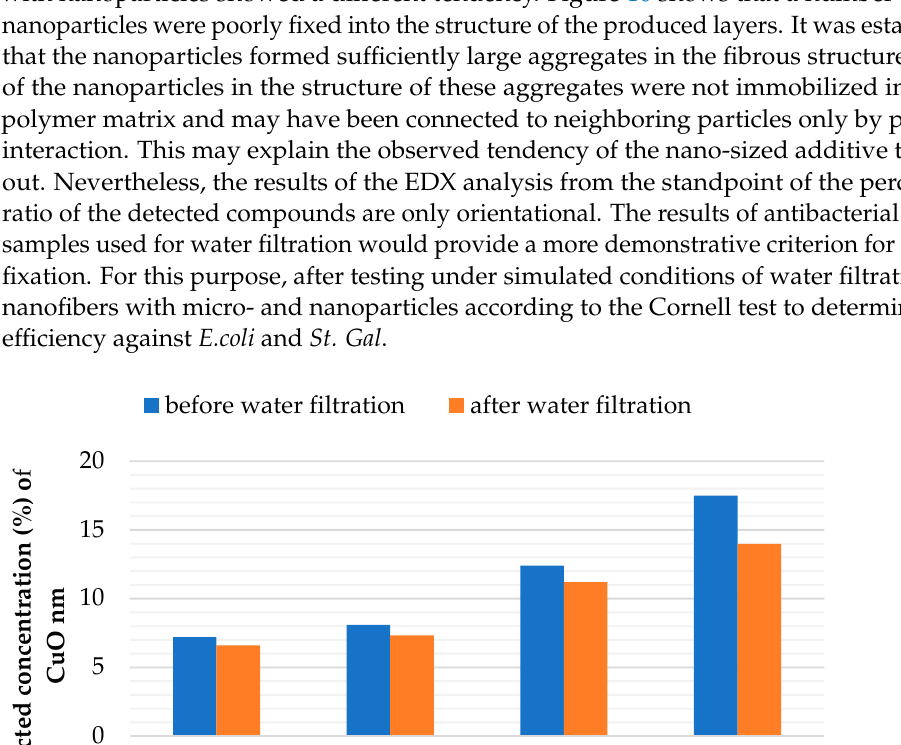
Table 8. Differences in antibacterial activity of samples with nanoparticles of CuO before and after treatment under the simulated conditions of water filtration (experiments with the electrode with a needle surface).